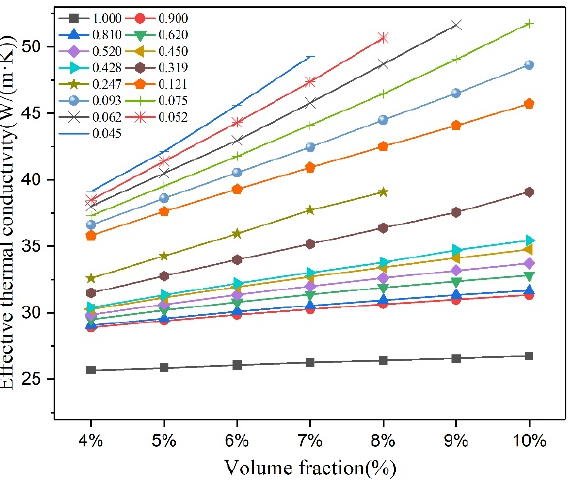
Figure 5. Effect of graphite volume fraction on effective thermal conductivity of cast iron, λ m = 25 W/(m · K).